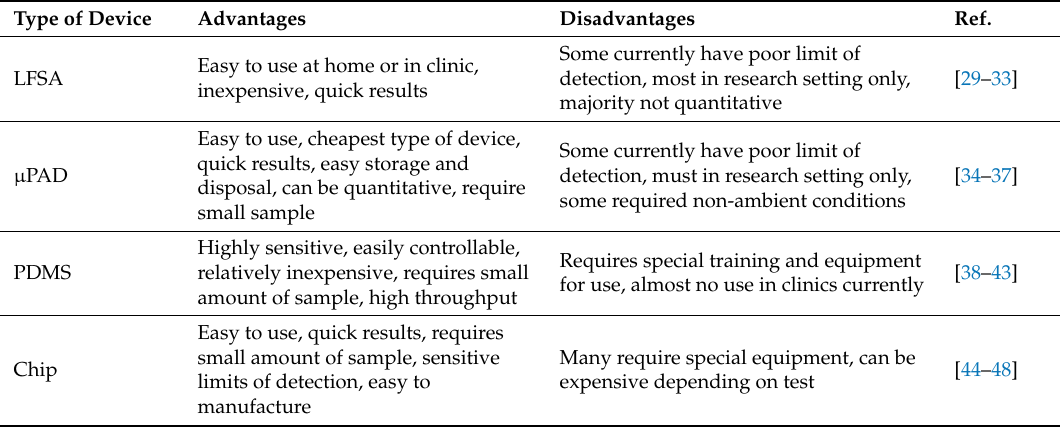
Table 2. Advantages and disadvantages of devices used to detect